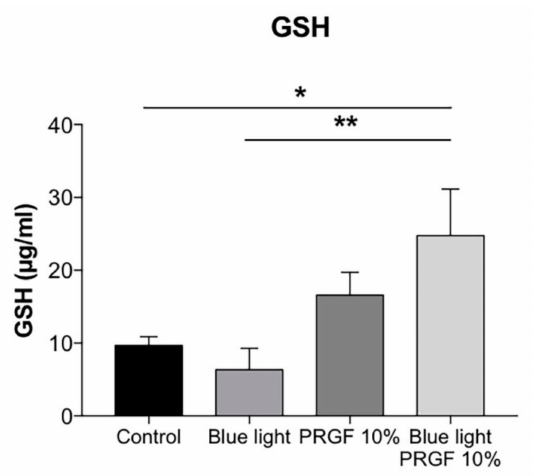
Figure 3. GSH quantification in ARPE19 cultures ( n = 4). Blue light reduced the concentration of GSH, while PRGF significantly increased GSH compared to control. Statistical analysis: One-way ANOVA, Tukey multiple comparison test, * p < 0.05, and ** p <